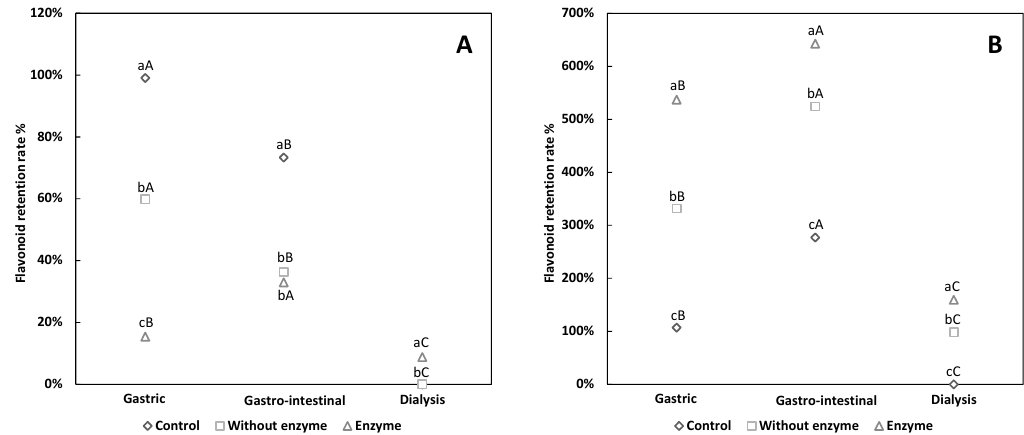
Figure 1. The flavonoid retention rate of walnut pigment from brown shell ( A ) and green husk ( B ) subjected to simulated in vitro gastric and intestinal digestion and dialysis (potential uptake). The data presented in this figure consist of average quantities ± standard deviation (SD) of three independent samples. Di ff erent letters in the bars within each group represent statistically significant di ff erences ( p < 0.05). “a–c” indicates a significant di ff erence in longitudinal, and “A–C” represents a significant di ff erence in lateral.